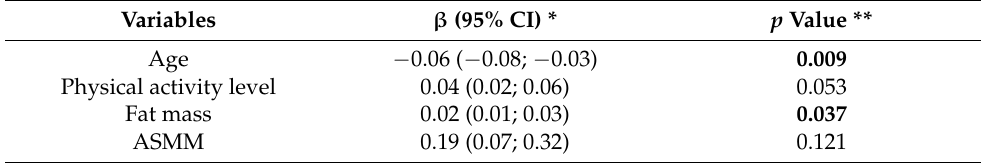
Table 3. Multivariable analysis of factors associated with the femoral neck T-score in women patients aged ≥ 75